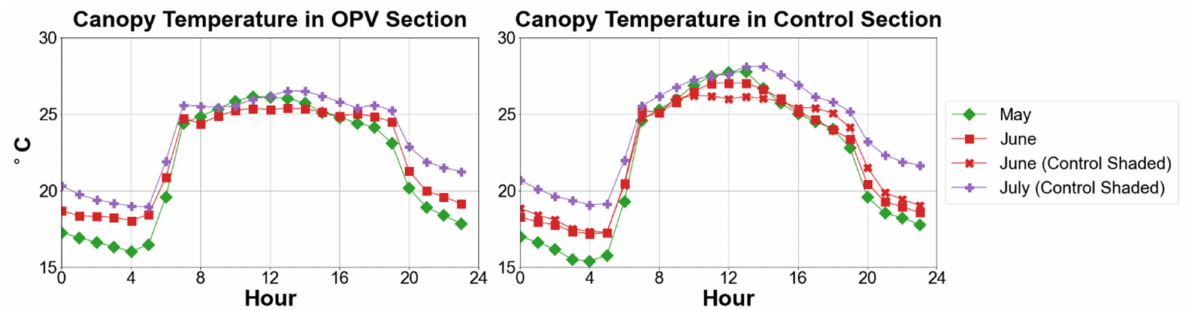
Figure 5. Average hourly values by month for canopy temperature ( ◦ C) in the OPV ( left ) and Control ( right ) sections of the greenhouse. A 30% shade net was deployed on the Control section, beginning on 11 June